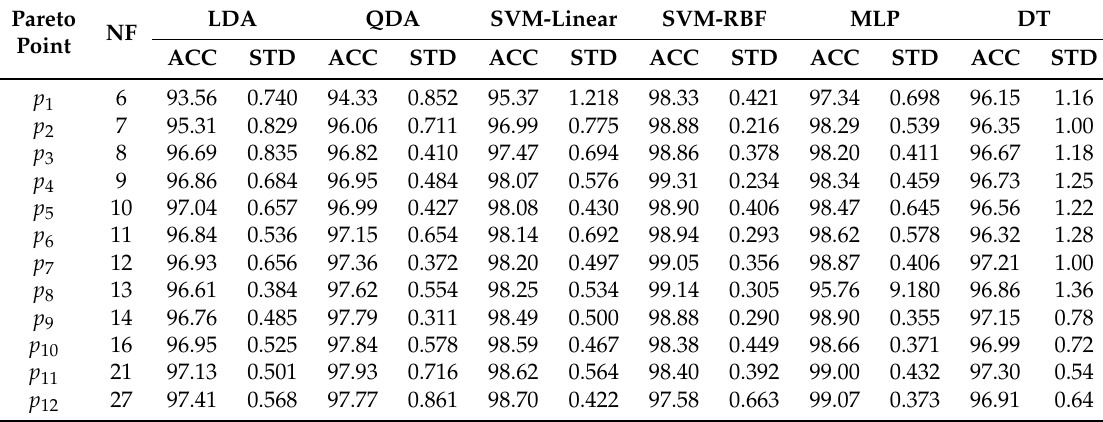
Table 6. Mean classification accuracy (ACC) and standard deviation (STD) for AB01 of classifiers trained with 13 different feature subsets. NF is the number of features in each